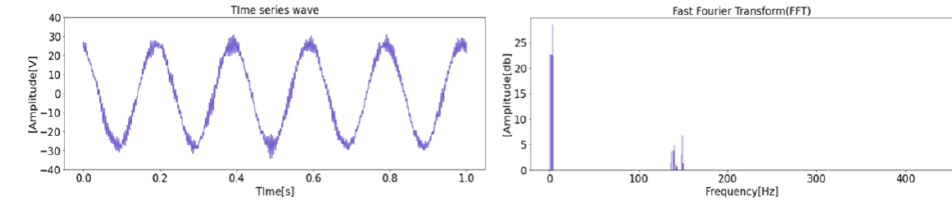
Figure 3. Fast Fourier transform (FFT) example acquired from the experiment.